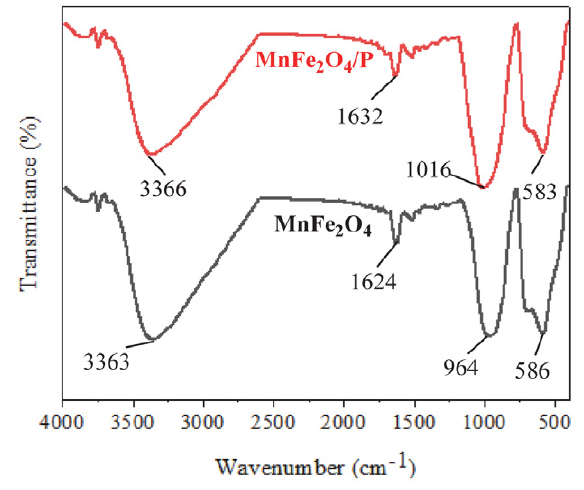
Figure 3. FTIR results for MnFe 2 O 4 nanoparticles before and after sorption of P ions